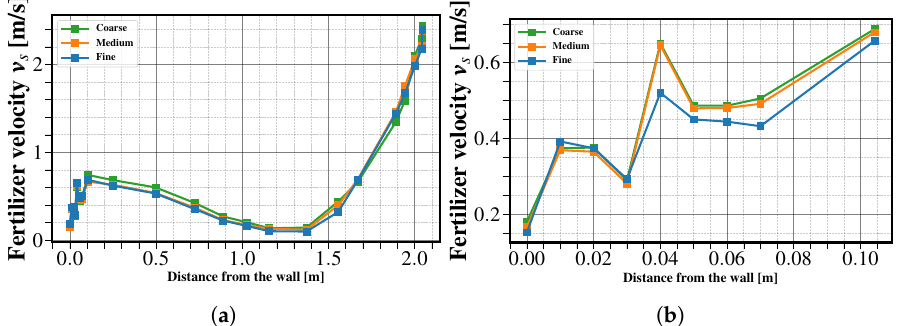
Figure 5. The velocity magnitude of particles (m/s) as a function of the distance ( a ) from the wall and ( b ) zoom in close to the wall for the case (8 rpm, 30% filling degree, and 3.57 ◦ inclination